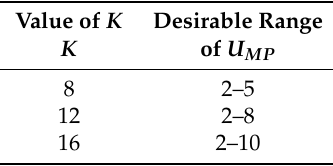
Table 3. Desirable range of the SNN density